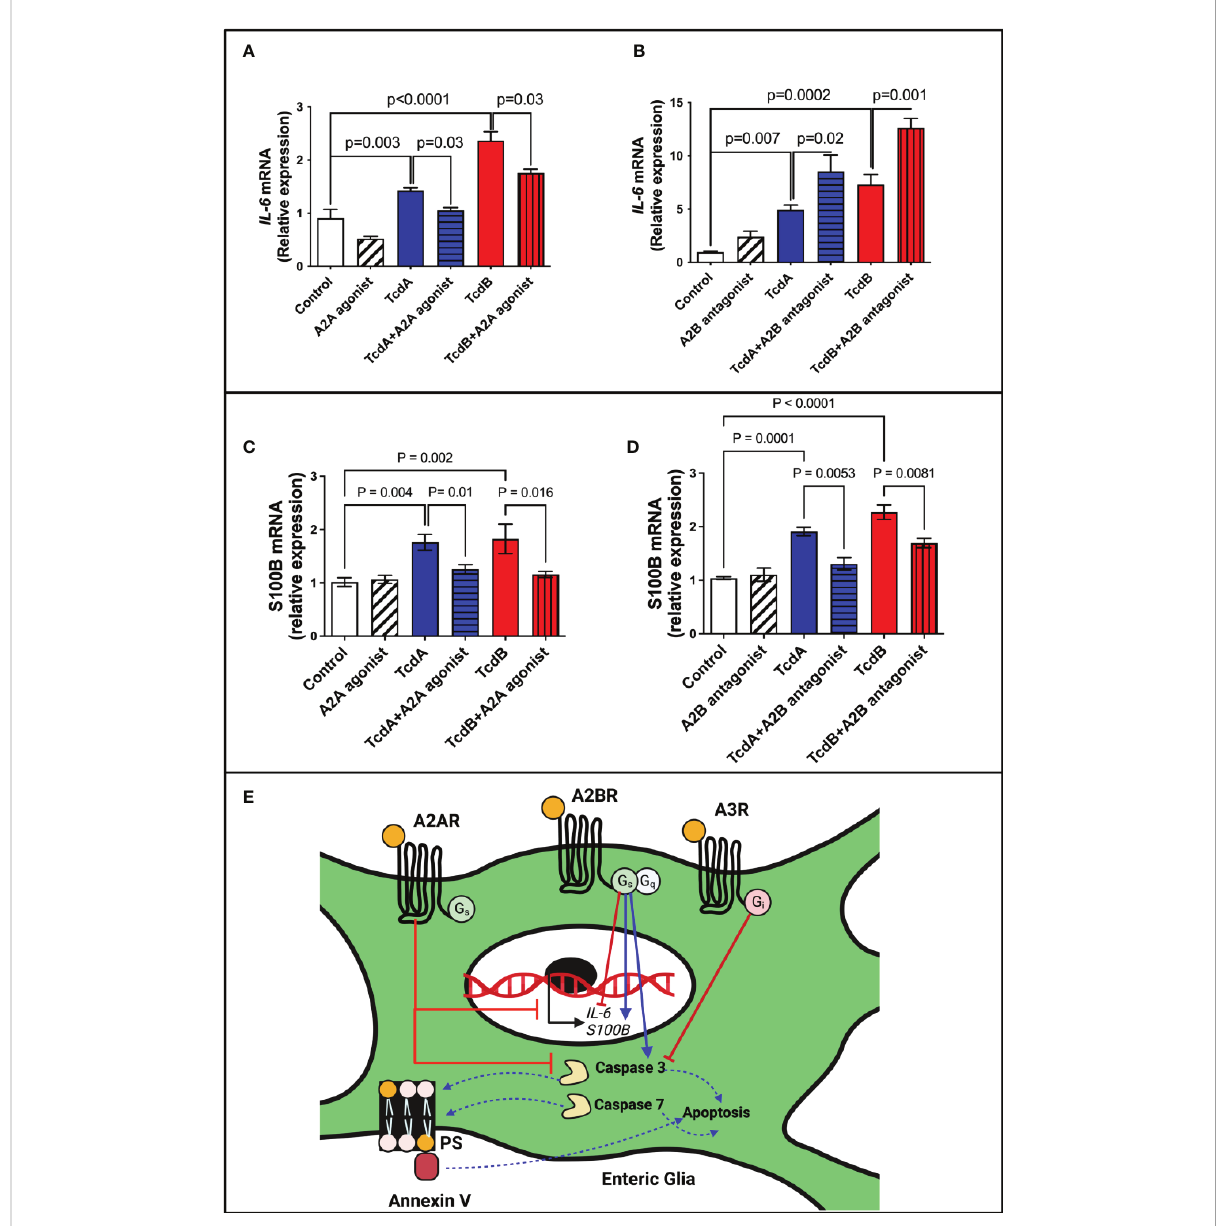
FIGURE 6 Regulation of IL-6 and S100B expression by adenosine receptors in EGCs challenged with C. dif fi cile toxins. (A, B) Analysis of IL-6 gene expression (mean ± s.e.m) by qPCR in enteroglial cell (EGC/PK060399) challenged with TcdA and TcdB for 18h in the presence or absence of (A) 300 µM ATL313 (an A2a-selective adenosine receptor agonist), and (B) 100 µM ATL801 (an A2b-selective adenosine receptor antagonist). (C, D) Analysis of S100B gene expression (mean ± s.e.m) by qPCR in enteroglial cell (EGC/PK060399) challenged with TcdA and TcdB for 18h in the presence or absence of (C) 300 µM ATL313 (an A2a-selective adenosine receptor agonist), and (D) 100 µM ATL801 (an A2b-selective adenosine receptor antagonist).These experiments are from two different replicates. (A – D) One-way ANOVA followed by Turkey test was used. (E) Proposed model of the role of adenosine receptors on deleterious effects induced by C . dif fi cile toxins on EGCs: C . dif fi cile toxins (TcdA and TcdB) upregulate A2A and A3 and downregulate A2B receptors in EGCs. Activation of A2A and A3, as well as inhibition of A2B lead to inhibition of caspase 3/7 activation and consequently inhibits cell death induced by C . dif fi cile toxins in a manner independently of PKA-CREB signaling. While A2A modulates S100B negatively, A2B promotes a positive effect in the expression of this mediator in EGCs challenge by C . dif fi cile toxins. While the modulation of IL-6 expression by adenosine receptors in EGCs challenged by TcdA and TcdB seem to be complex, A2A decreasing its expression and A2B showing an opposite